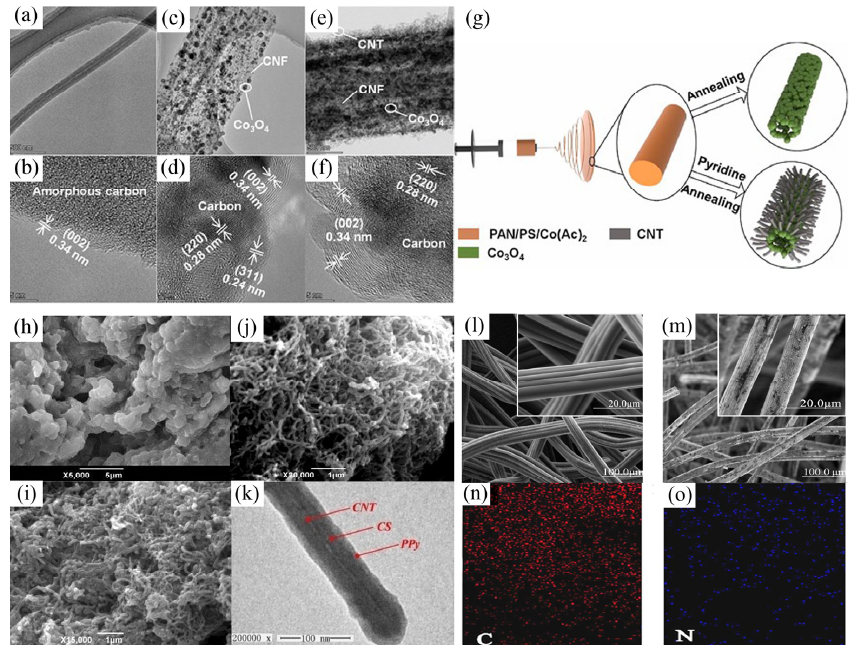
Figure 4. TEM images of as-prepared CNF ( a , b ), Co 3 O 4 @CNF ( c , d ) and Co 3 O 4 @CNF@CNT ( e , f ); ( g ) the preparation schematic of Co 3 O 4 @CNF and Co 3 O 4 @CNF@CNT. Reprinted from Reference [82]